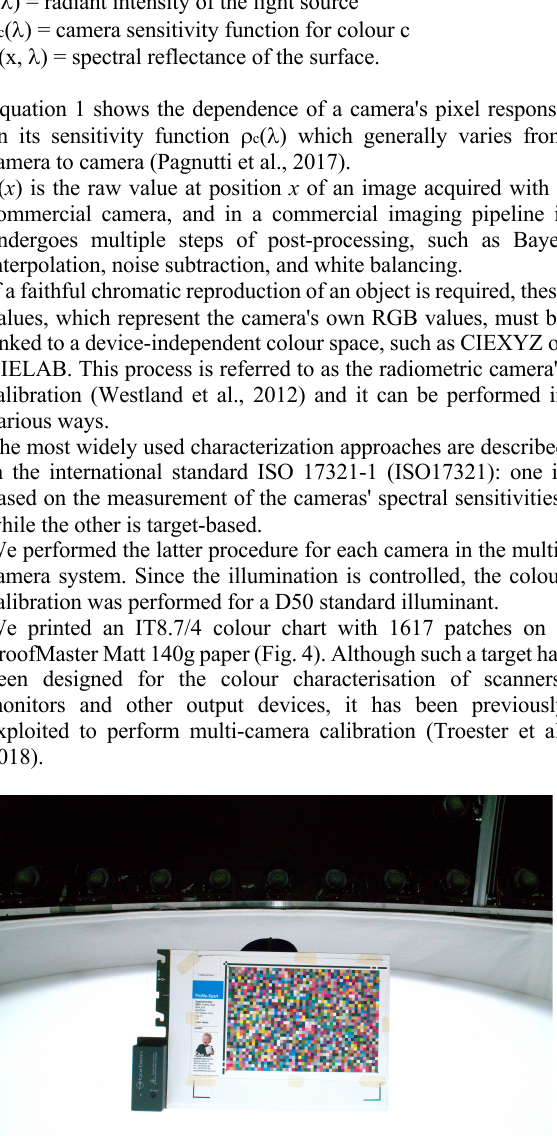
Figure 3: example of a full camera network used for the geometric calibration. Figure 4: Example of captured IT8.7/4 colour